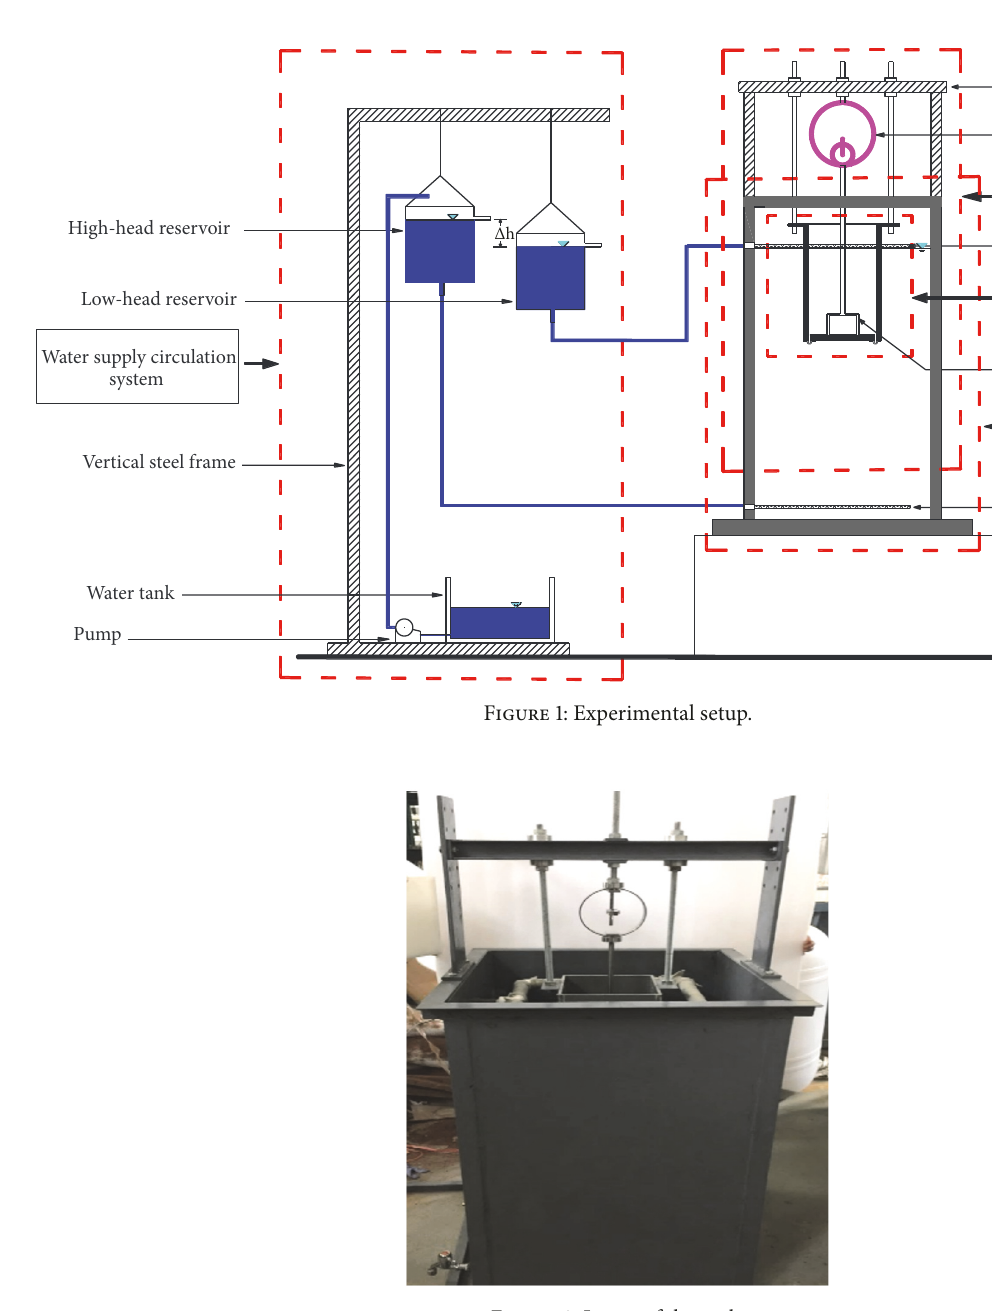
Figure 2: Image of the